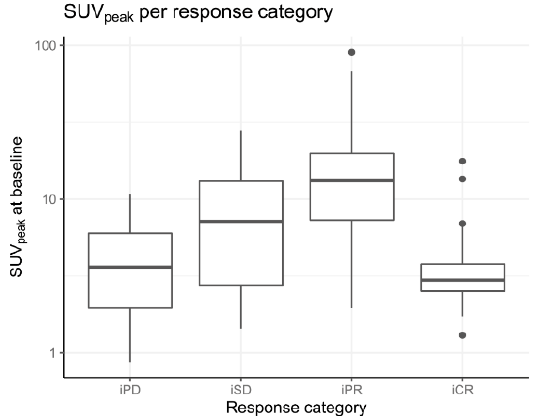
Figure 4. SUV peak values per response category on the tumor-level. Legend: iCR = Imaging complete response, iPD = Imaging progression disease, iPR = Imaging partial response, iSD = Imaging stable disease, SUV = Standardized uptake value.